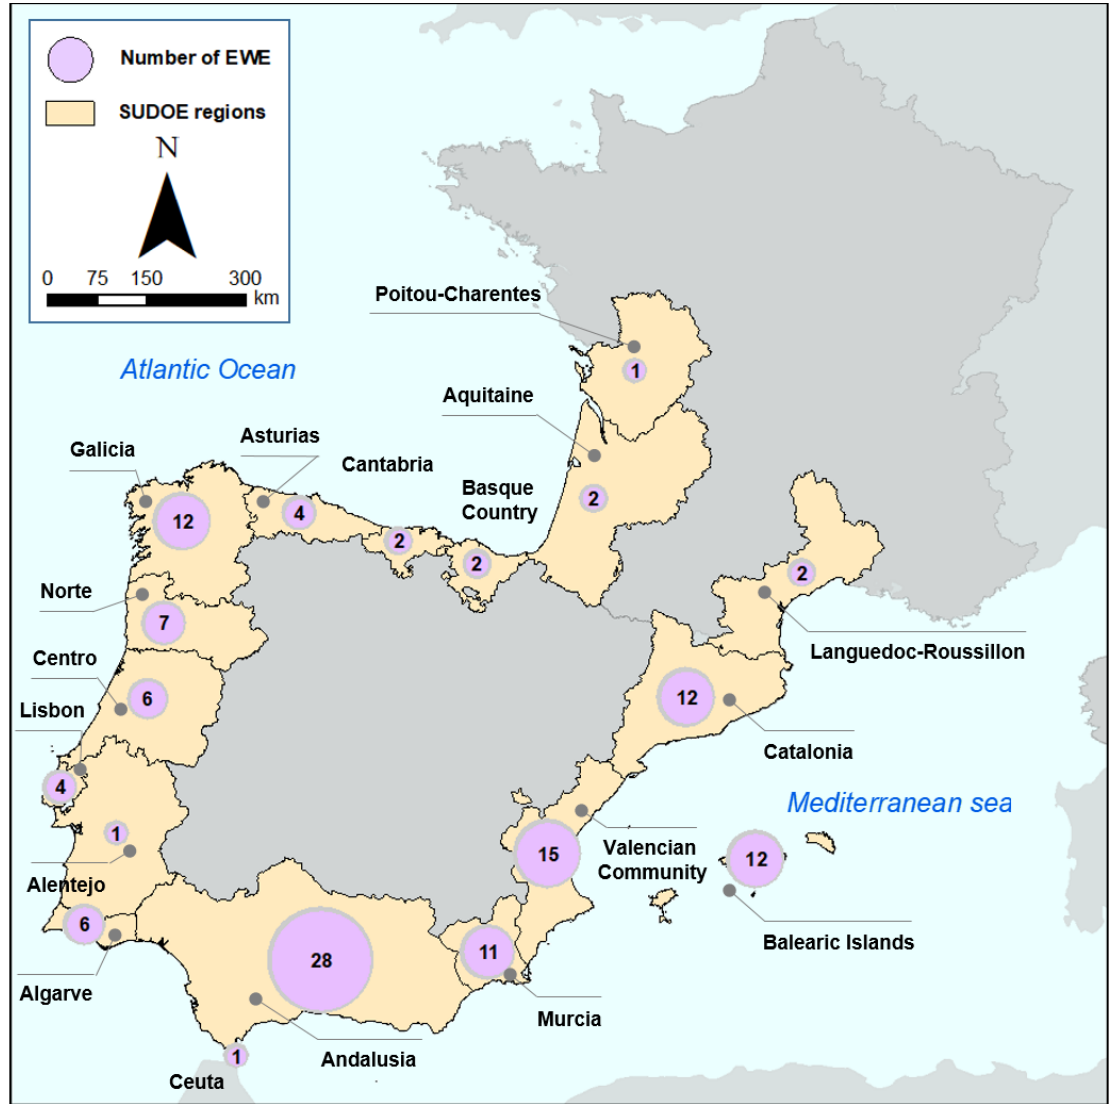
Figure 3. Representation of the number of extreme weather events in each of the unit-regions analysed. The Spanish Mediterranean coast, particularly the region of Andalusia, stands out with the highest number of events recorded. Note that the sum of the number of events in this figure exceeds the 95 inventoried, as some of them have an interregional dimension and are counted more than once. Below is an analysis by country, identifying the most catastrophic events in each